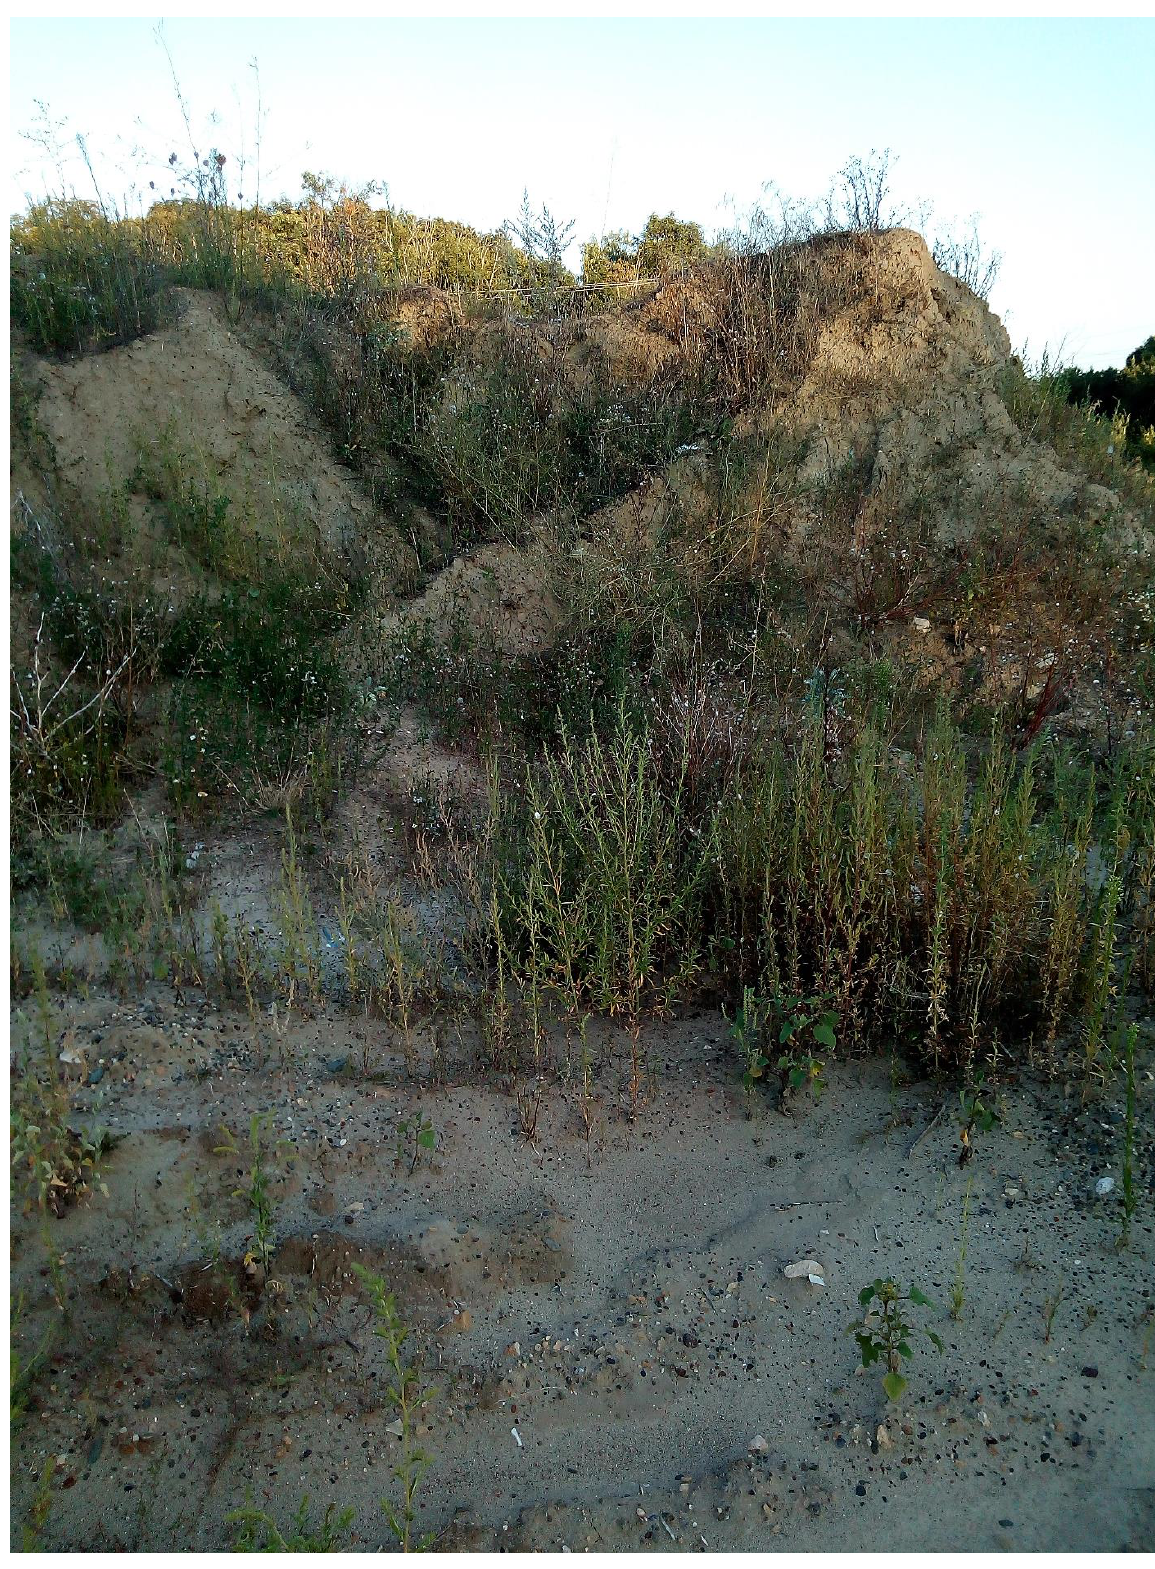
Рис. 2. Песчано-галечниковый холм с рудеральной растительностью на окраине г. Михайловска (Ставропольский край) – место обнаружения крупной популяции Compsolacon crenicollis (фотография Козьминых В.О. вечером 9 августа 2019